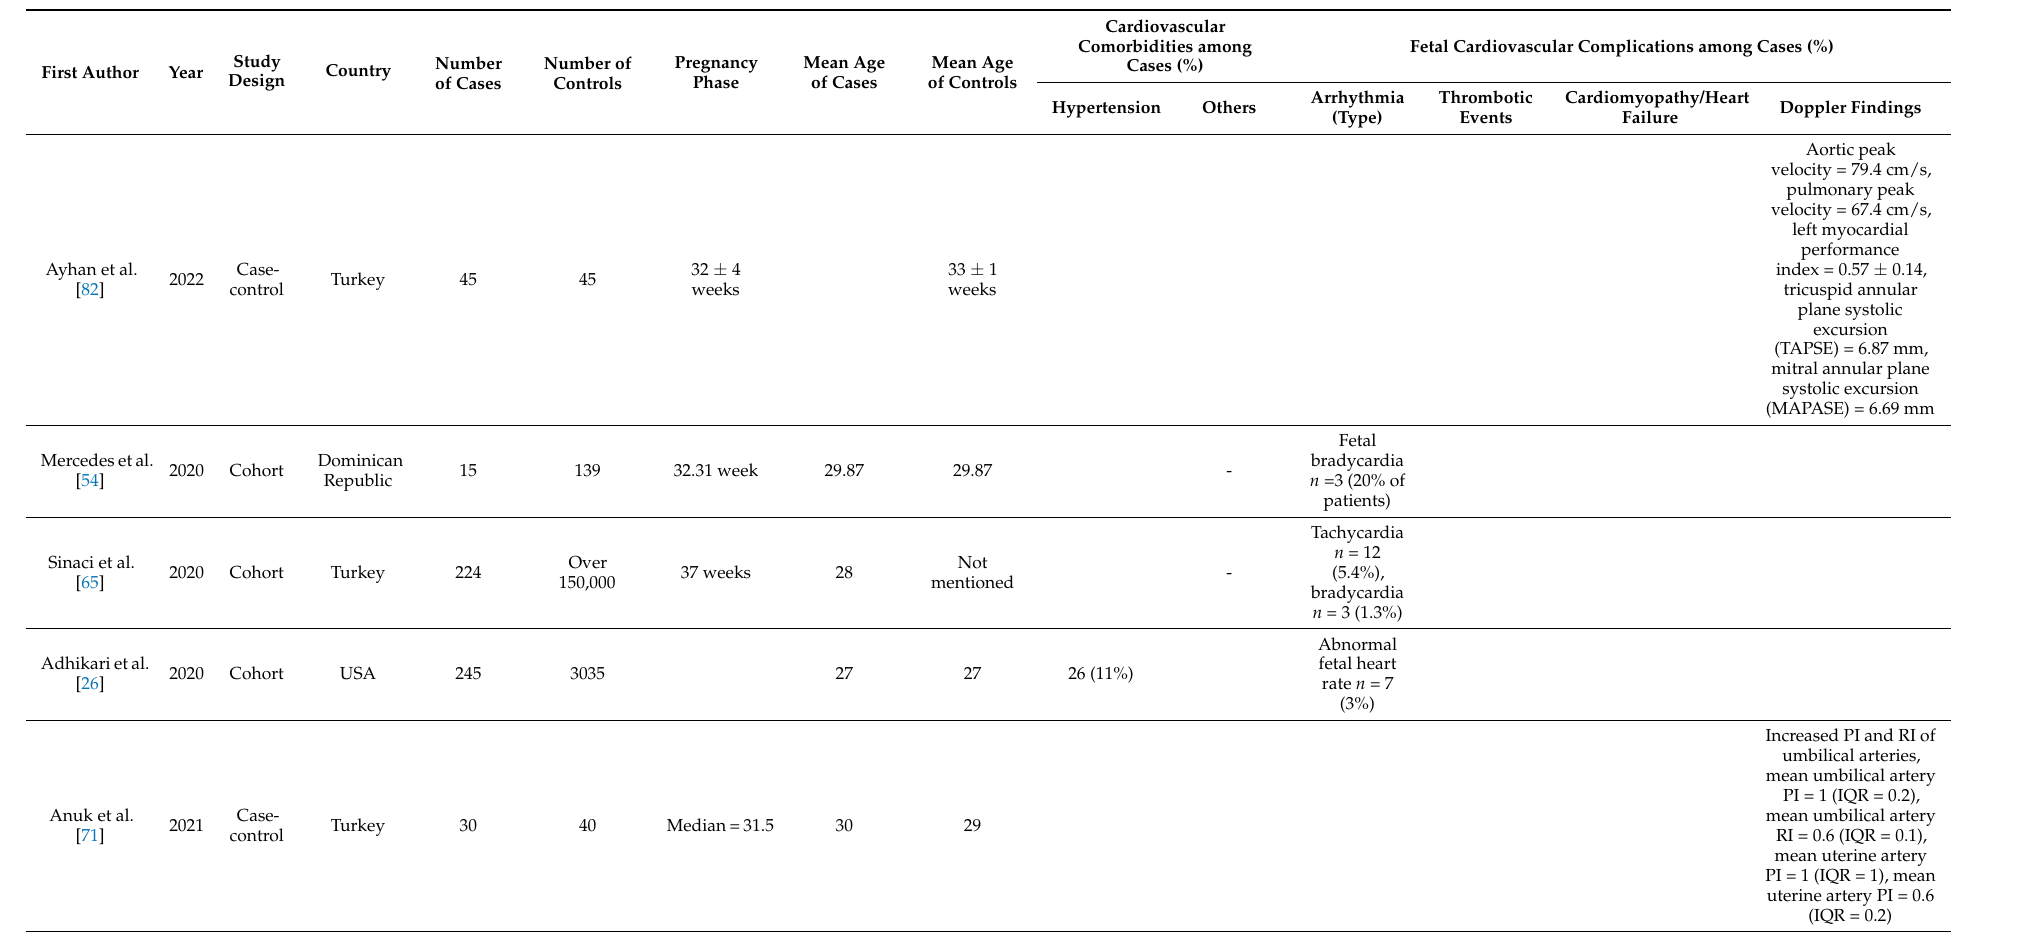
Table 2. Characteristics and fetal outcomes of the included cohort/cross-sectional/case-control